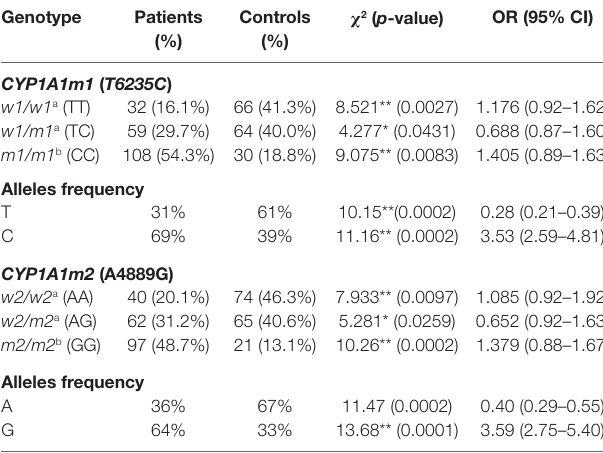
TaBle 2 | Association between the CYP1A1m1 and CYP1A1m2 genotype and allele frequencies and breast cancer risk among patients and in the healthy